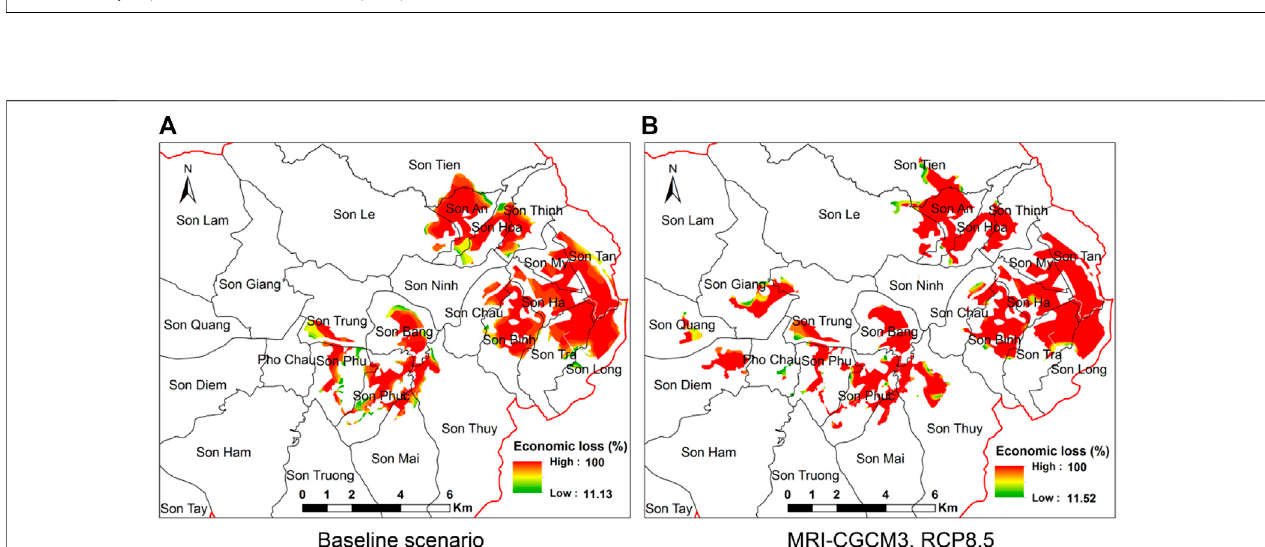
FIGURE 13 | Loss of rice in percentage due to fl ooding under baseline and MRI-CGCM3, RCP8.5 scenarios.